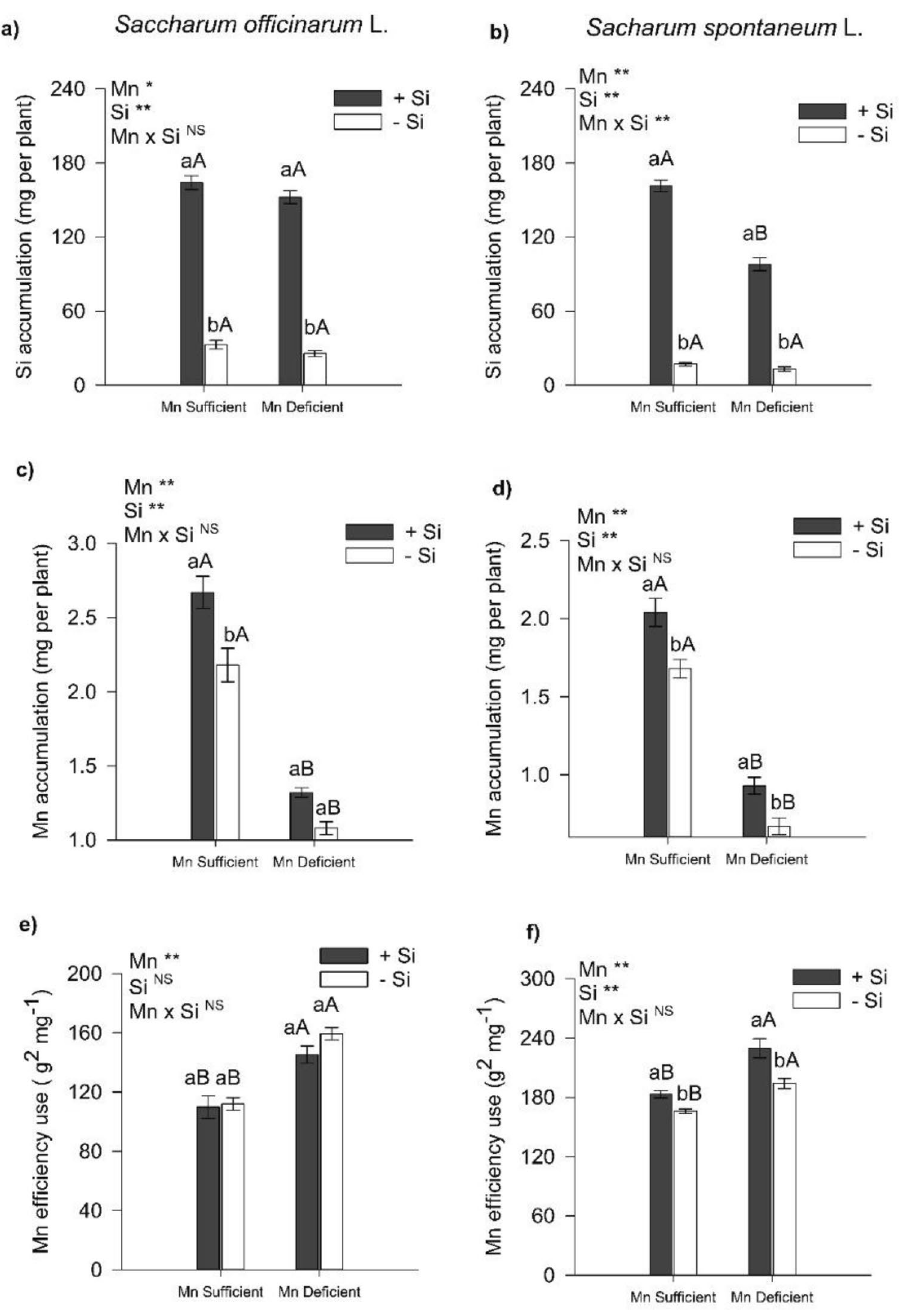
Figure 1. Si ( a , b ) and Mn accumulation ( c , d ) and Mn use efficiency ( e , f ) of sugarcane ( Saccharum officinarum L.) and energy cane ( Saccharum spontaneum L.) plants, respectively, grown in Mn-sufficient and deficient nutrient solution in the absence (− Si) and presence (+ Si) of Si. F-test was applied: * (p ≤ 0.05); **(p ≤ 0.01), and ns not significant. Different lowercase letters compare Si conditions under the same Mn condition (p < 0.05 by Tukey test), while different uppercase letters compare Mn conditions under the same Si condition (p < 0.05 by Tukey test). Bars represent the mean standard error, n =